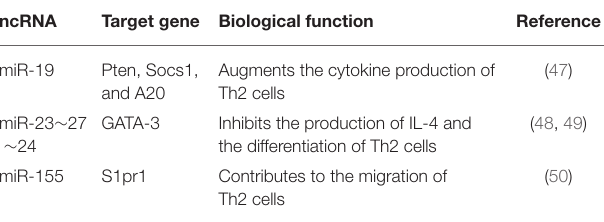
TABLE 3 | ncRNAs involved in Th2